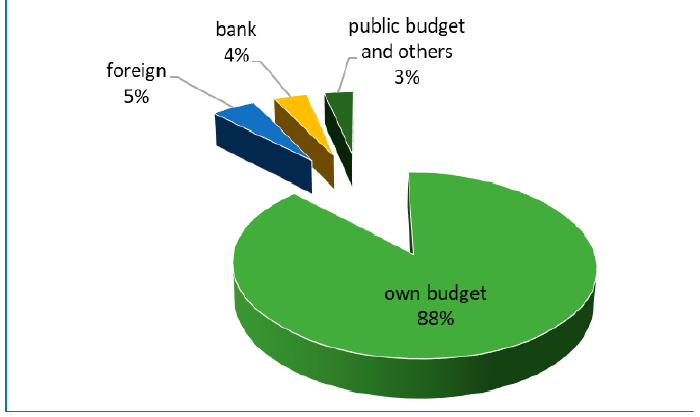
Figure 6. Sources of expenditures on ICT and innovation in the steel industry (manufacturers of basic metals) in Poland. Source: Data from GUS [122].